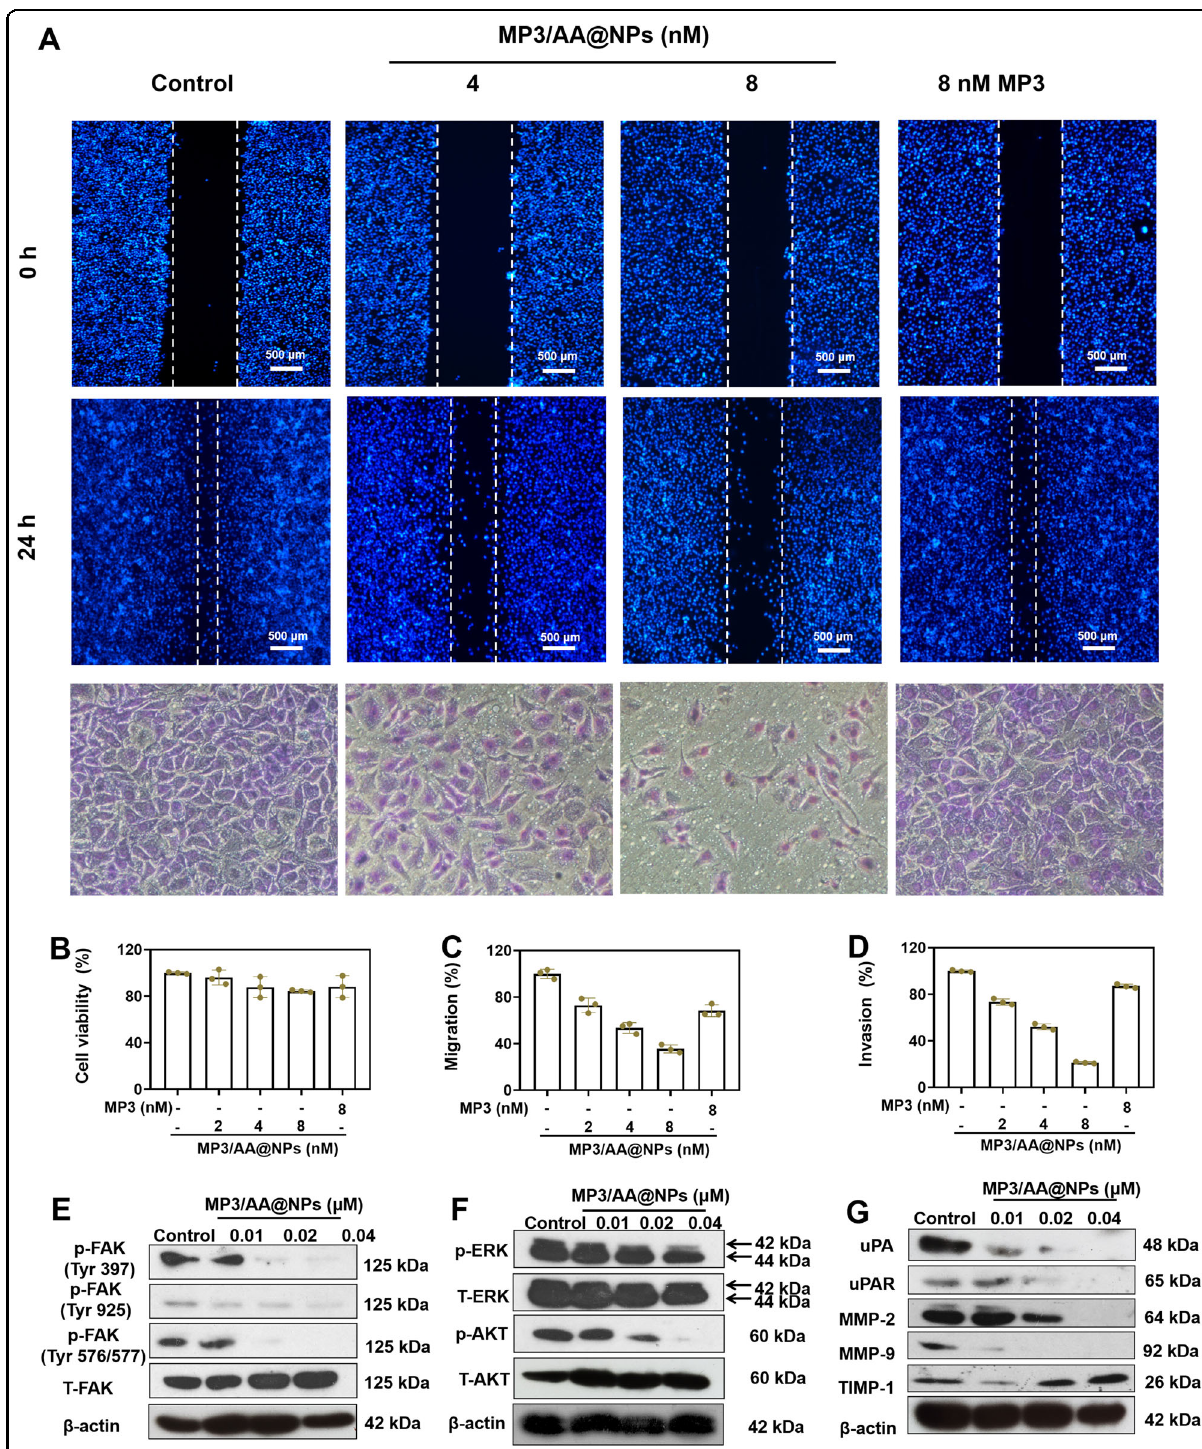
Fig. 4 The inhibitory activity of nanoparticles on cell migration and invasion. A Antimigration and anti-invasion of MP3 and MP3/AA@NPs. B The cytotoxic effects against and C , D the corresponding migrated and invaded MDA-MB-231 cells after treatment with MP3 or different concentrations of MP3/AA@NPs. E – G Western blot test of the expression of migration- and invasion-related proteins in MDA-MB-231 cells received different concentrations of MP3/AA@NPs